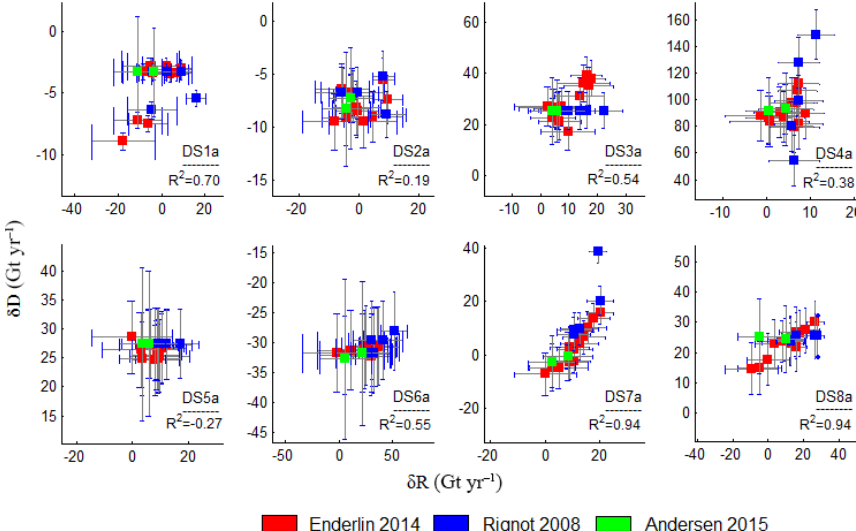
Figure 2. Correlation between the anomaly of the discharge δD with respect to a reference SMB ( y axis) and the 4-year averaged runoff δR ( x axis) in GrIS regions. The symbols with different colors refer to different estimations of D . The grey bars for both δD and δR indicate the errors. The correlation coefficients R 2 are also shown in each